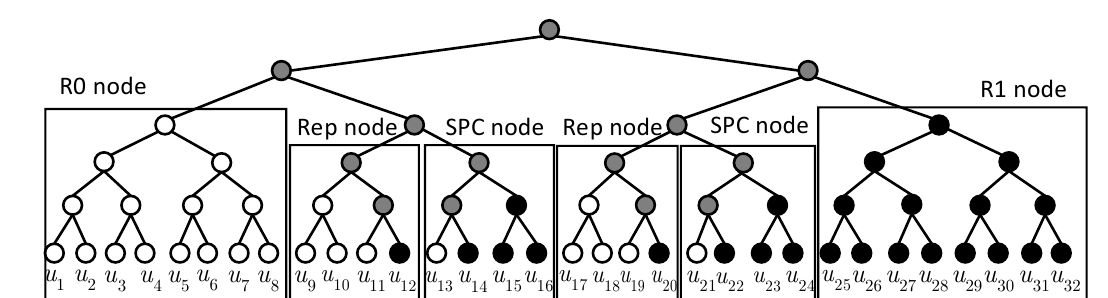
Figure 5. Schematic diagram of subcode classification.